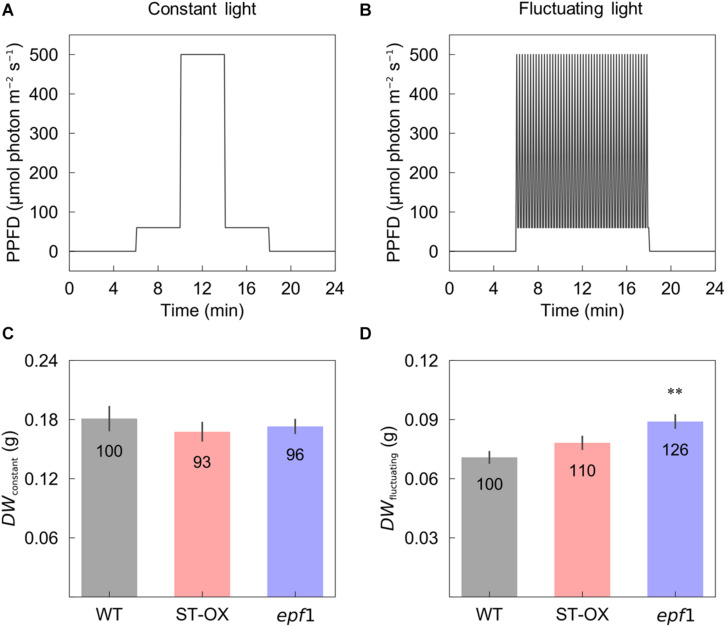
Biomass production under the constant and fluctuating light conditions. Dry weight of the above ground biomass was evaluated in the three lines of Arabidopsis under (C) the constant (DWconstant) and (D) fluctuating (DWfluctuating) light conditions as described in (A) and (B). Vertical bars indicate the standard error (n = 4). ** indicates significant differences in each parameter between WT and each transgenic line at p < 0.01, according to Dunnett’s test. The values in each column represent the relative value of each line to WT.